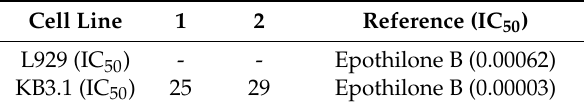
Table 2. Cytotoxic activities of 1 and 2 (in vitro cytotoxicity (IC 50 ) in µ g / mL). Cell